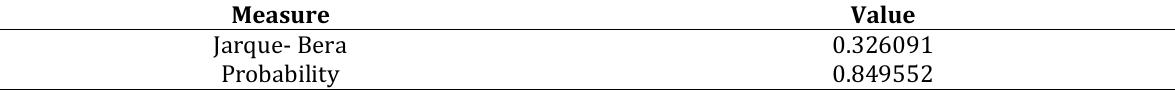
Table 24: Normality Test: Jarque-Bera test Measure